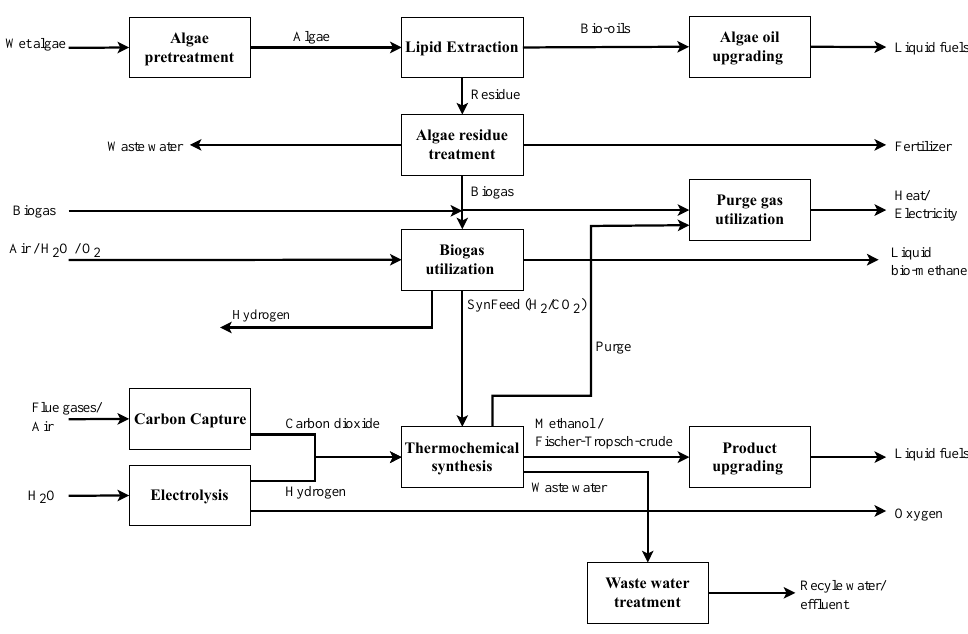
Figure 1. Simplified renewable refinery representation (detailed superstructure representation with all unit-operations can be found in Appendix A, Table A1 and Figure A1).